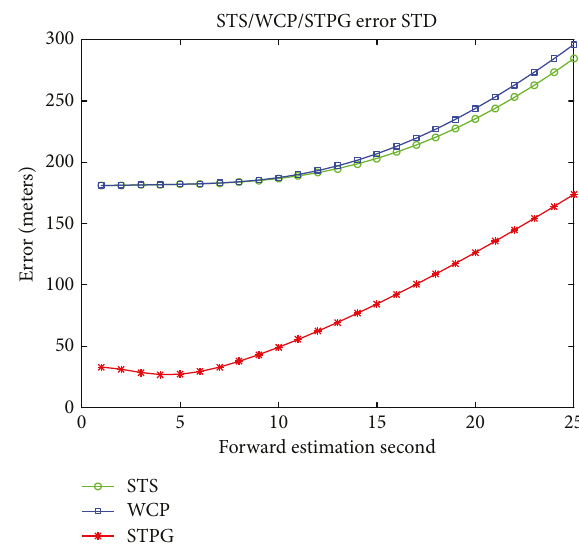
Figure 16: STS versus WCP versus STPG error STD.